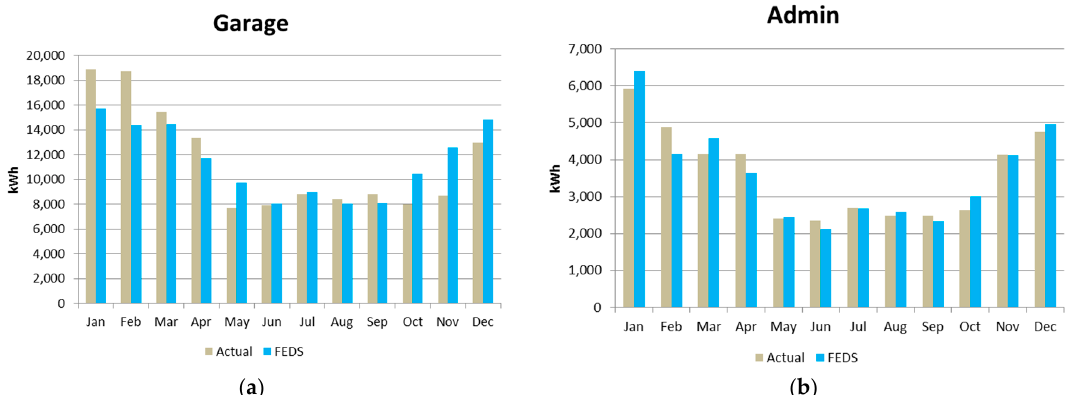
Figure 7. Results of FEDS simulated model calibration show monthly electricity consumption vs. actuals for the DPW garage ( a ) and administrative building ( b ).